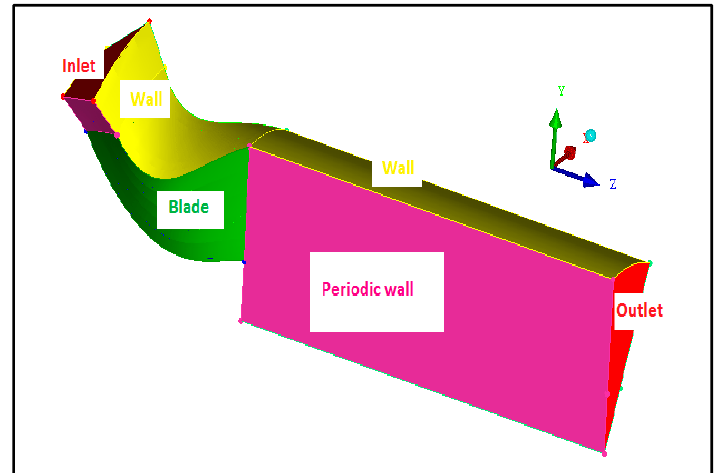
Figure 5. The different parts of the boundary condition.